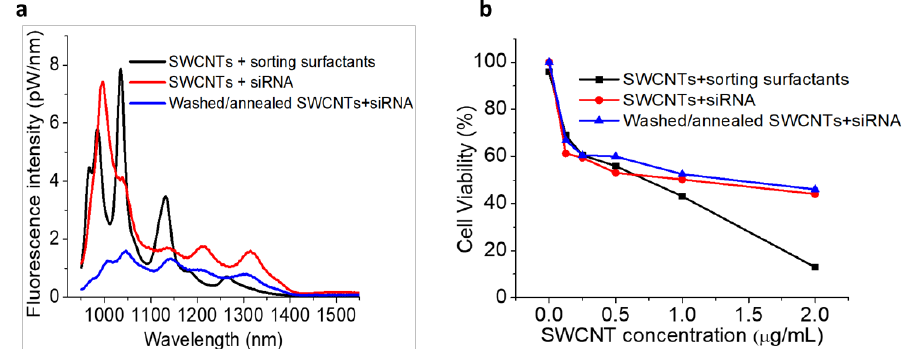
Figure 3. ( a ) Fluorescence spectra of raw SWCNTs dispersed with sorting surfactants, raw